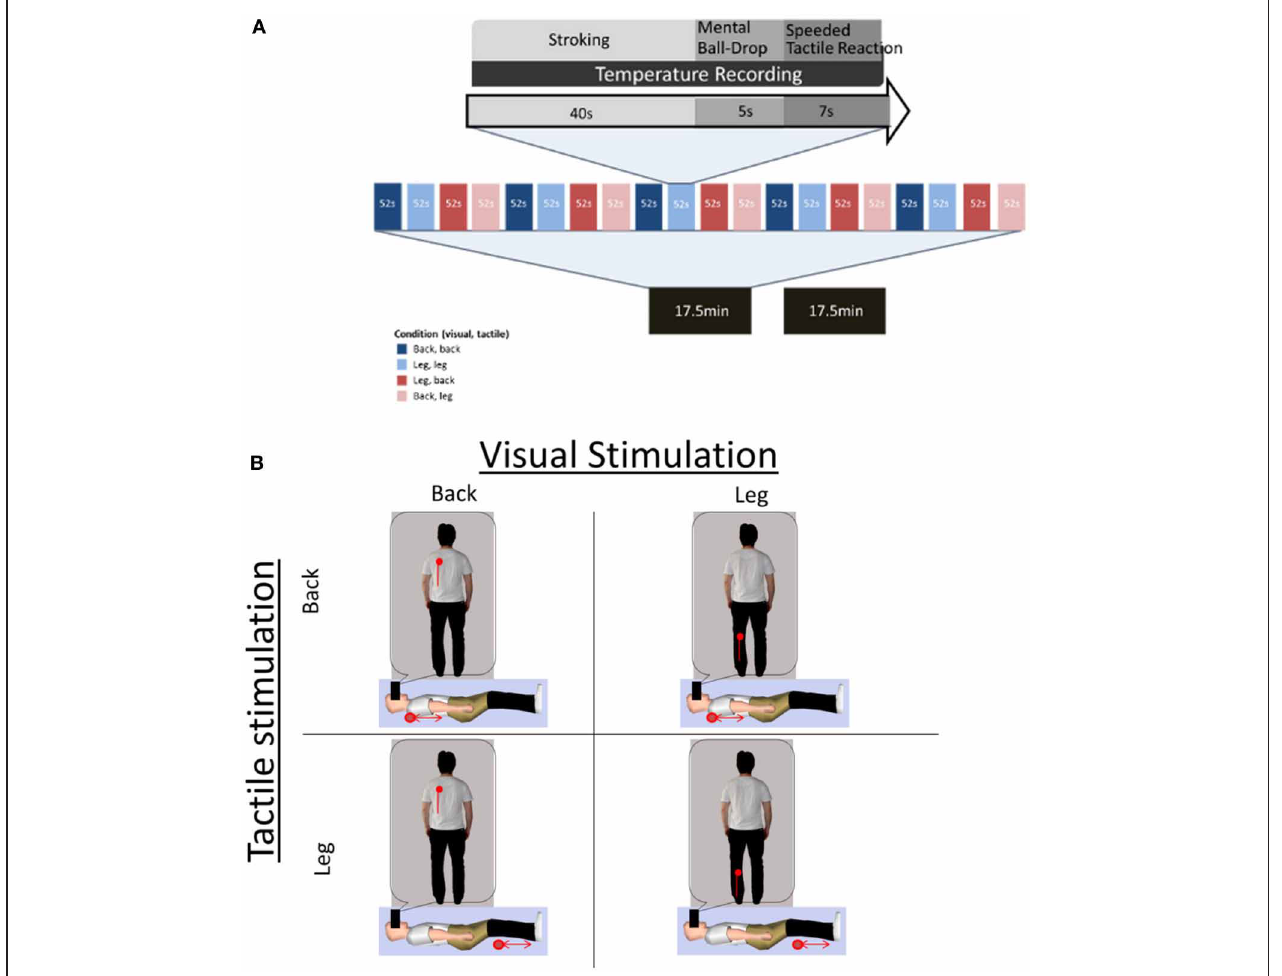
FIGURE 2 | Experimental paradigm and factorial design. (A) Experimental procedure of each trial (top), each block (20 trials-middle), and full experiment (two blocks-bottom). (B) Factorial design of the experiment: The four panels show different visuo-tactile stroking conditions. Participants lay supine and received tactile stroking on the back or leg (red dot and arrow represent